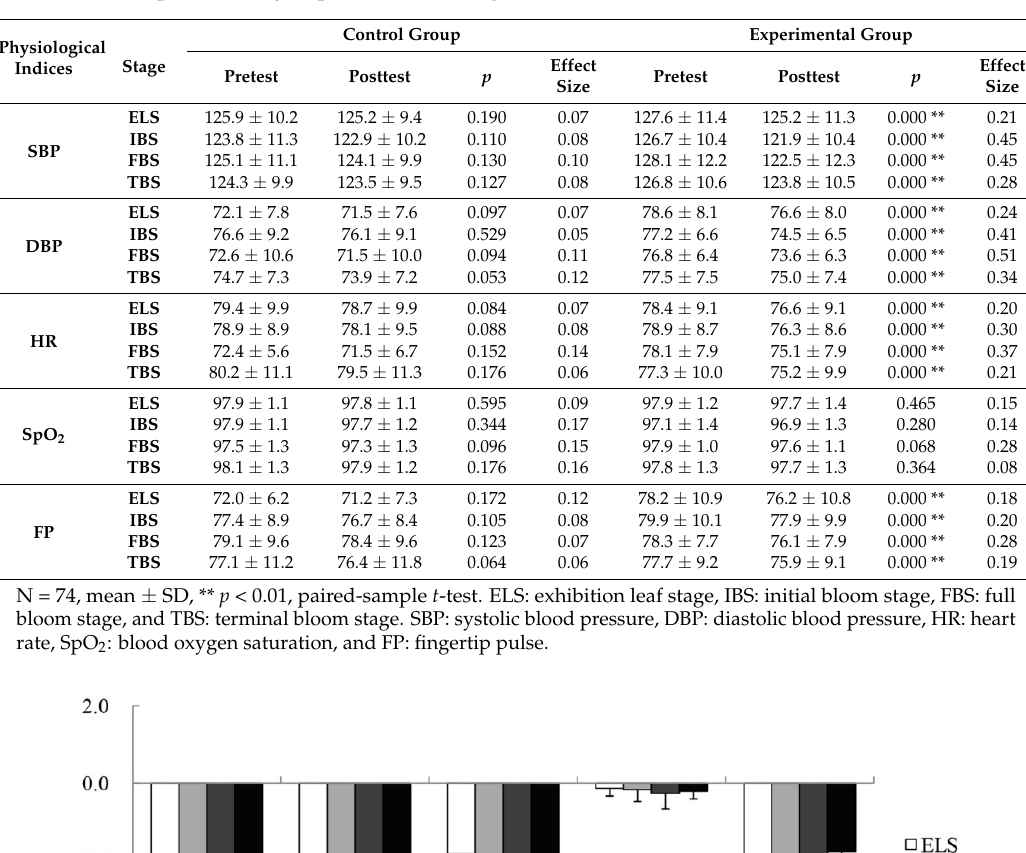
Table 2. The pre- and post-measurement variable values of participants’ physiological indices in the control and experimental groups across four stages.